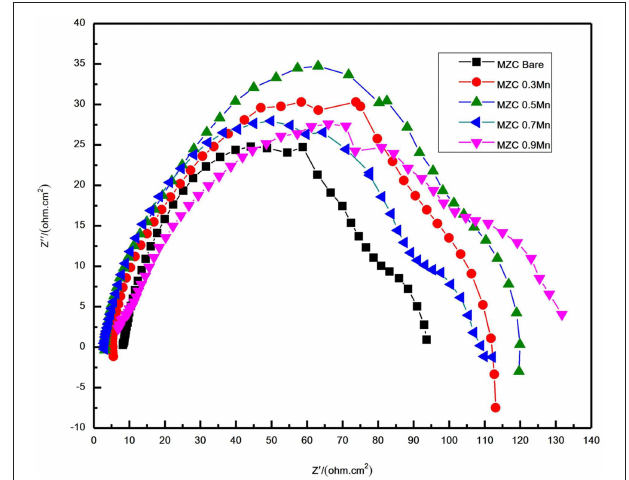
FIGURE 11 | The alternating current impedance spectra of as-extruded MZC, MZC0.3Mn, MZC0.5Mn, MZC0.7Mn, and MZC0.9Mn alloys.